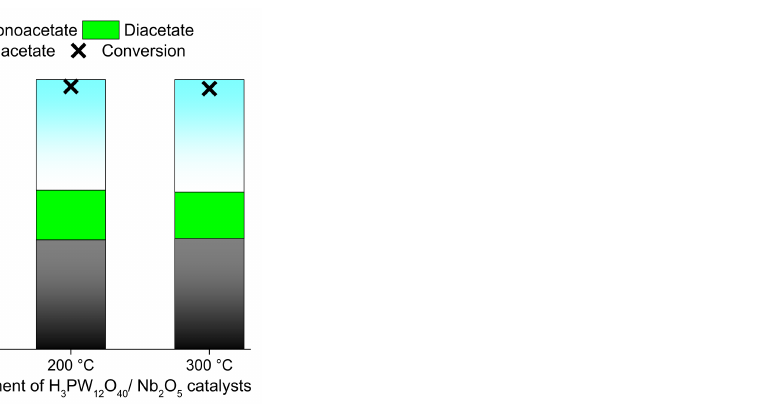
Figure 29. Conversion and selectivities in the glycerol esterification over thermally treated Niobium- supported HPA catalysts. Reaction conditions: glycerol (24 mmol), acetyl acetate (140 mmol), catalyst (30 wt. %), temperature (60 ◦ C), time (12 h).